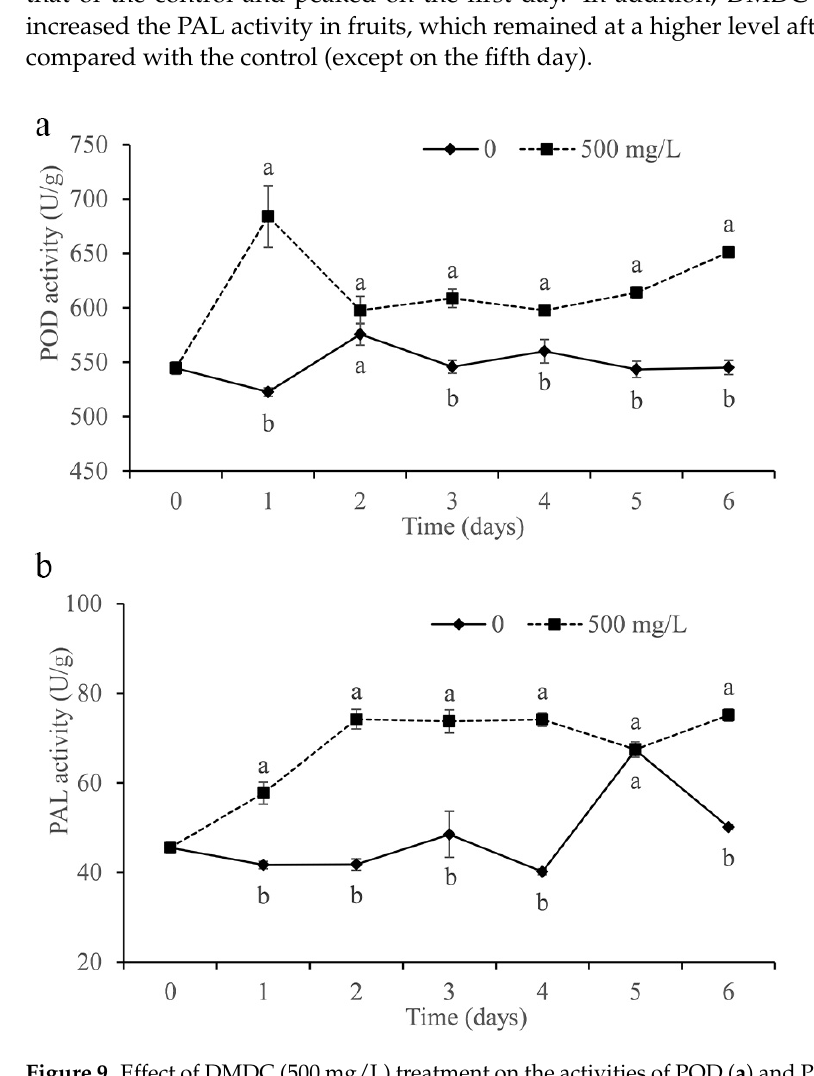
Figure 9. Effect of DMDC (500 mg/L) treatment on the activities of POD ( a ) and PAL ( b ) in citrus fruit. The data represent the mean ± standard deviation (SD). Different letters on each column represent significant differences ( p < 0.05 ) according to a t-test.